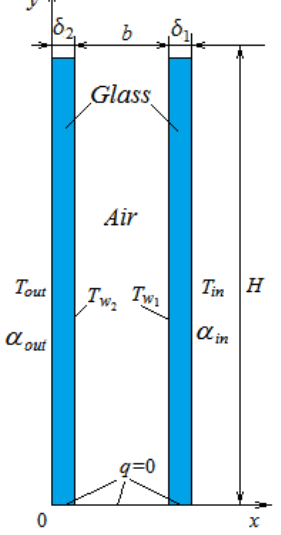
Figure 1. Geometrical model of a double-pane window.